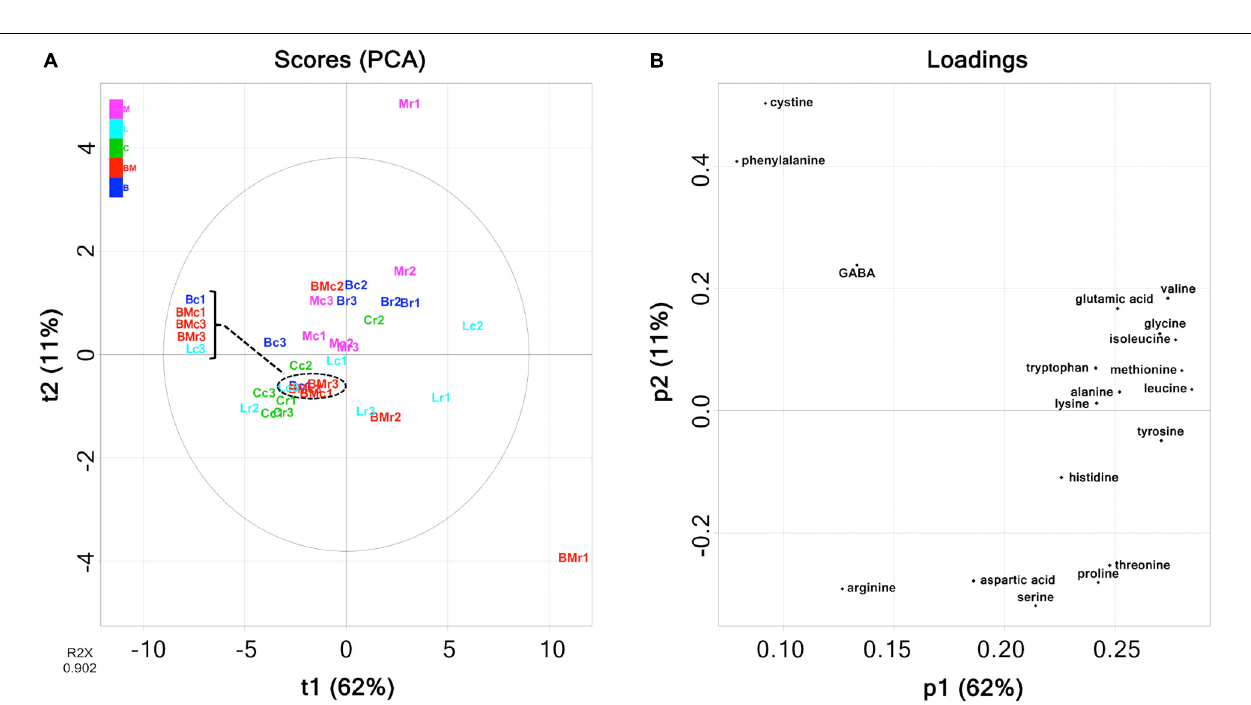
FIGURE 5 | Abundances of free amino acids in 30 cheese samples. The total amount of free amino acids in each sample are shown in the barplot. B, Brie de Meaux; BM, Brie de Melun; C, Coulommiers; L, Langres; M, Maroilles.